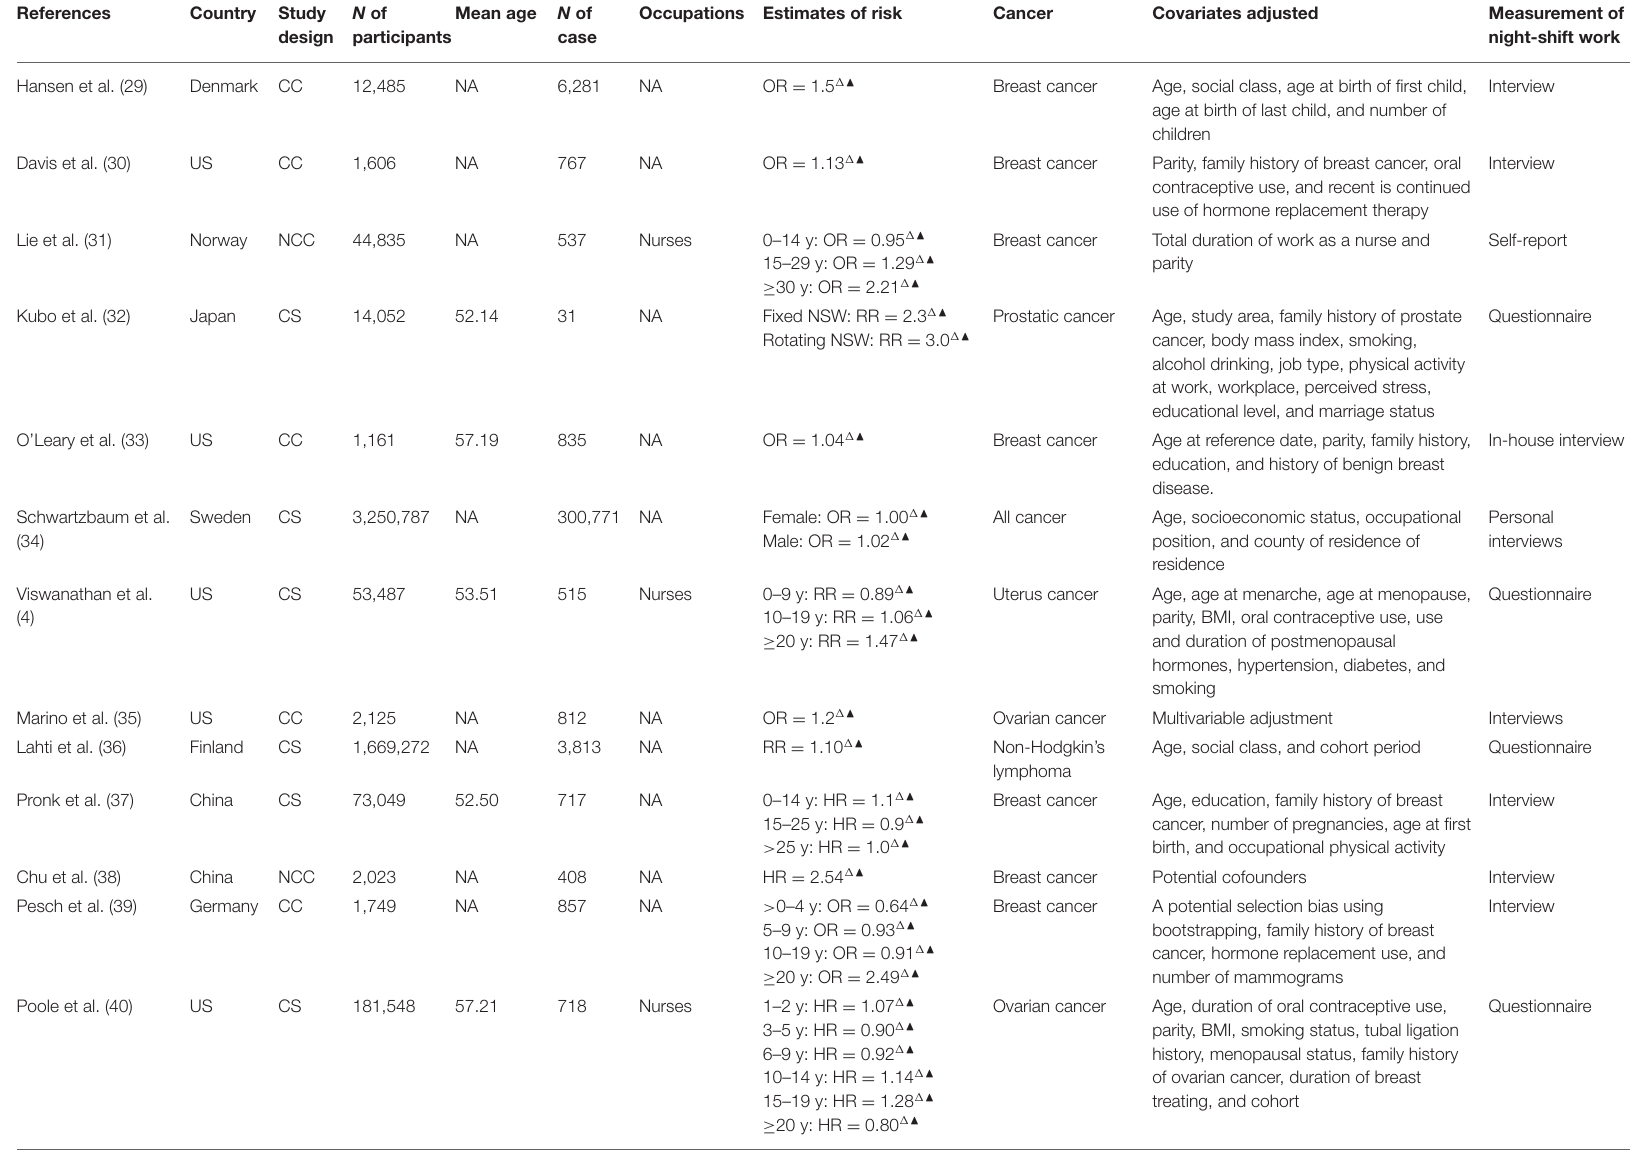
TABLE 1 | Characteristics of included studies.